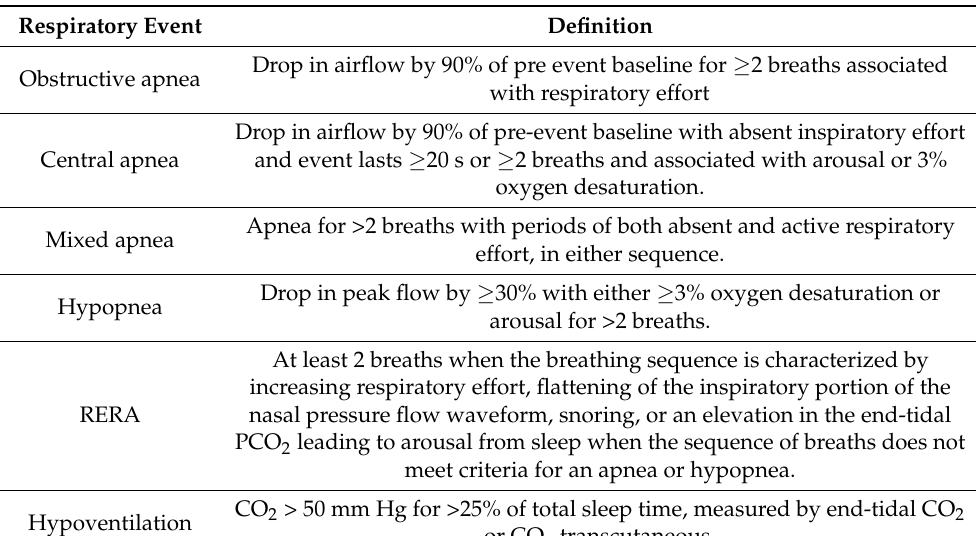
Table 3. 2015 AASM Guidelines for the scoring of pediatric respiratory events